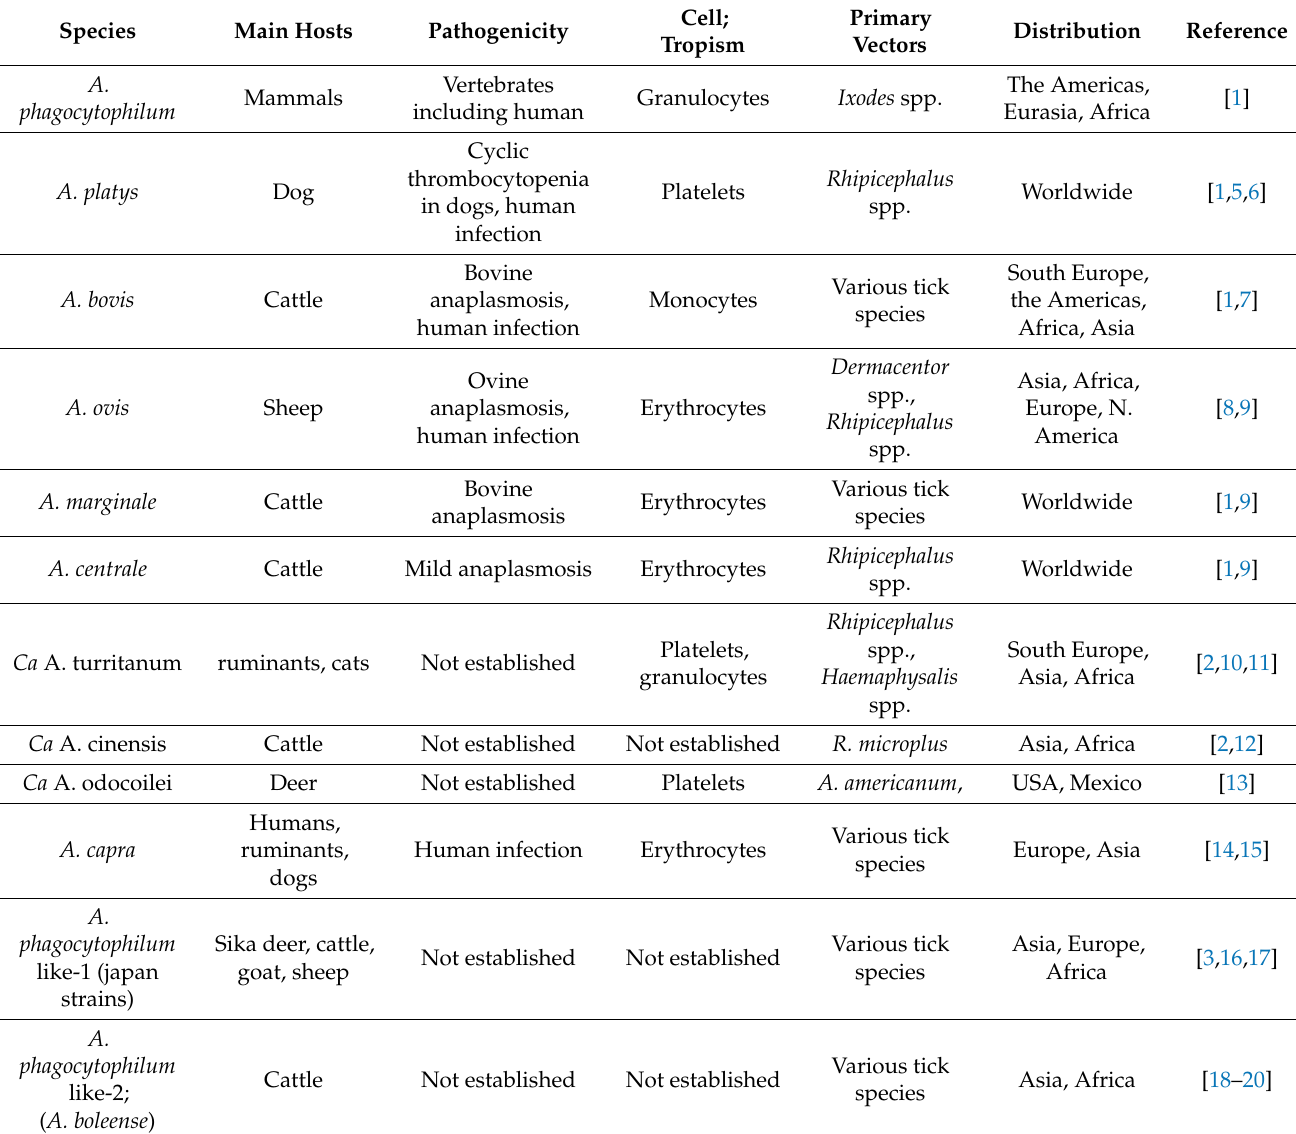
Table 1. Characteristics of Anaplasma species and unclassified genovariants 1